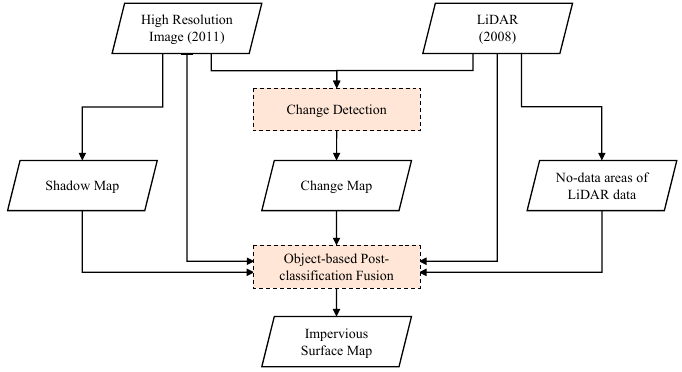
Figure 3. Flowchart of the proposed method. The multi-sensor data acquired at different time were process by change detection to obtain the change map. The shadow map and no-data areas of LiDAR data were obtained separately. Finally, the multi-source data were interpreted by the proposed object-based post-classification fusion with the shadow map, change map, and no-data areas. The accurate impervious surface map was generated for the result.